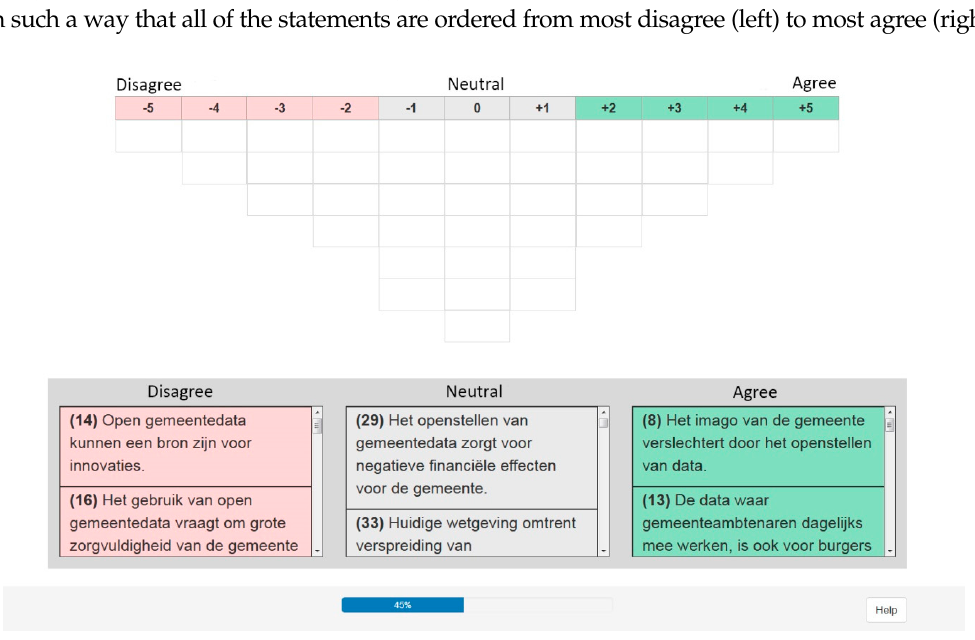
Figure A1. Sorting scheme online survey.